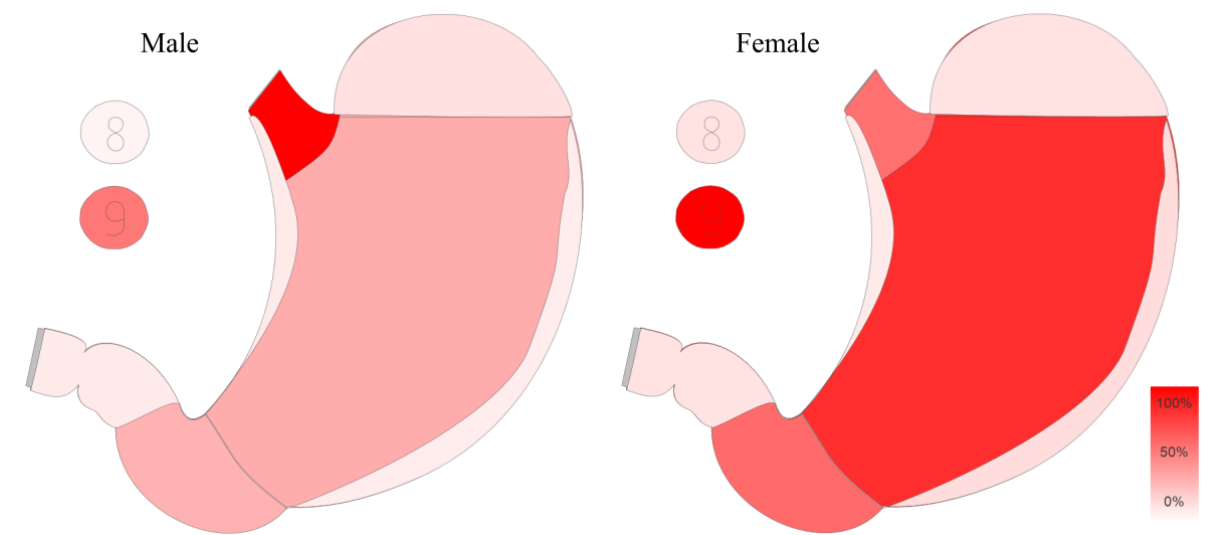
Figure 5. Comparison of two different cohorts within the organ map module. Different patterns of occurrence for female and male stomach cancer cases are evident. The color saturation is linear to the occurrence, with 100% saturation being the most affected